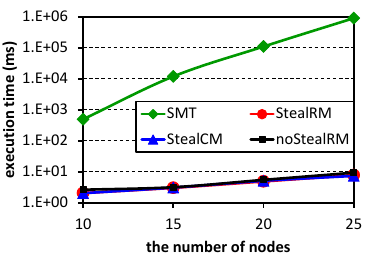
Figure 7. Execution time comparison among all